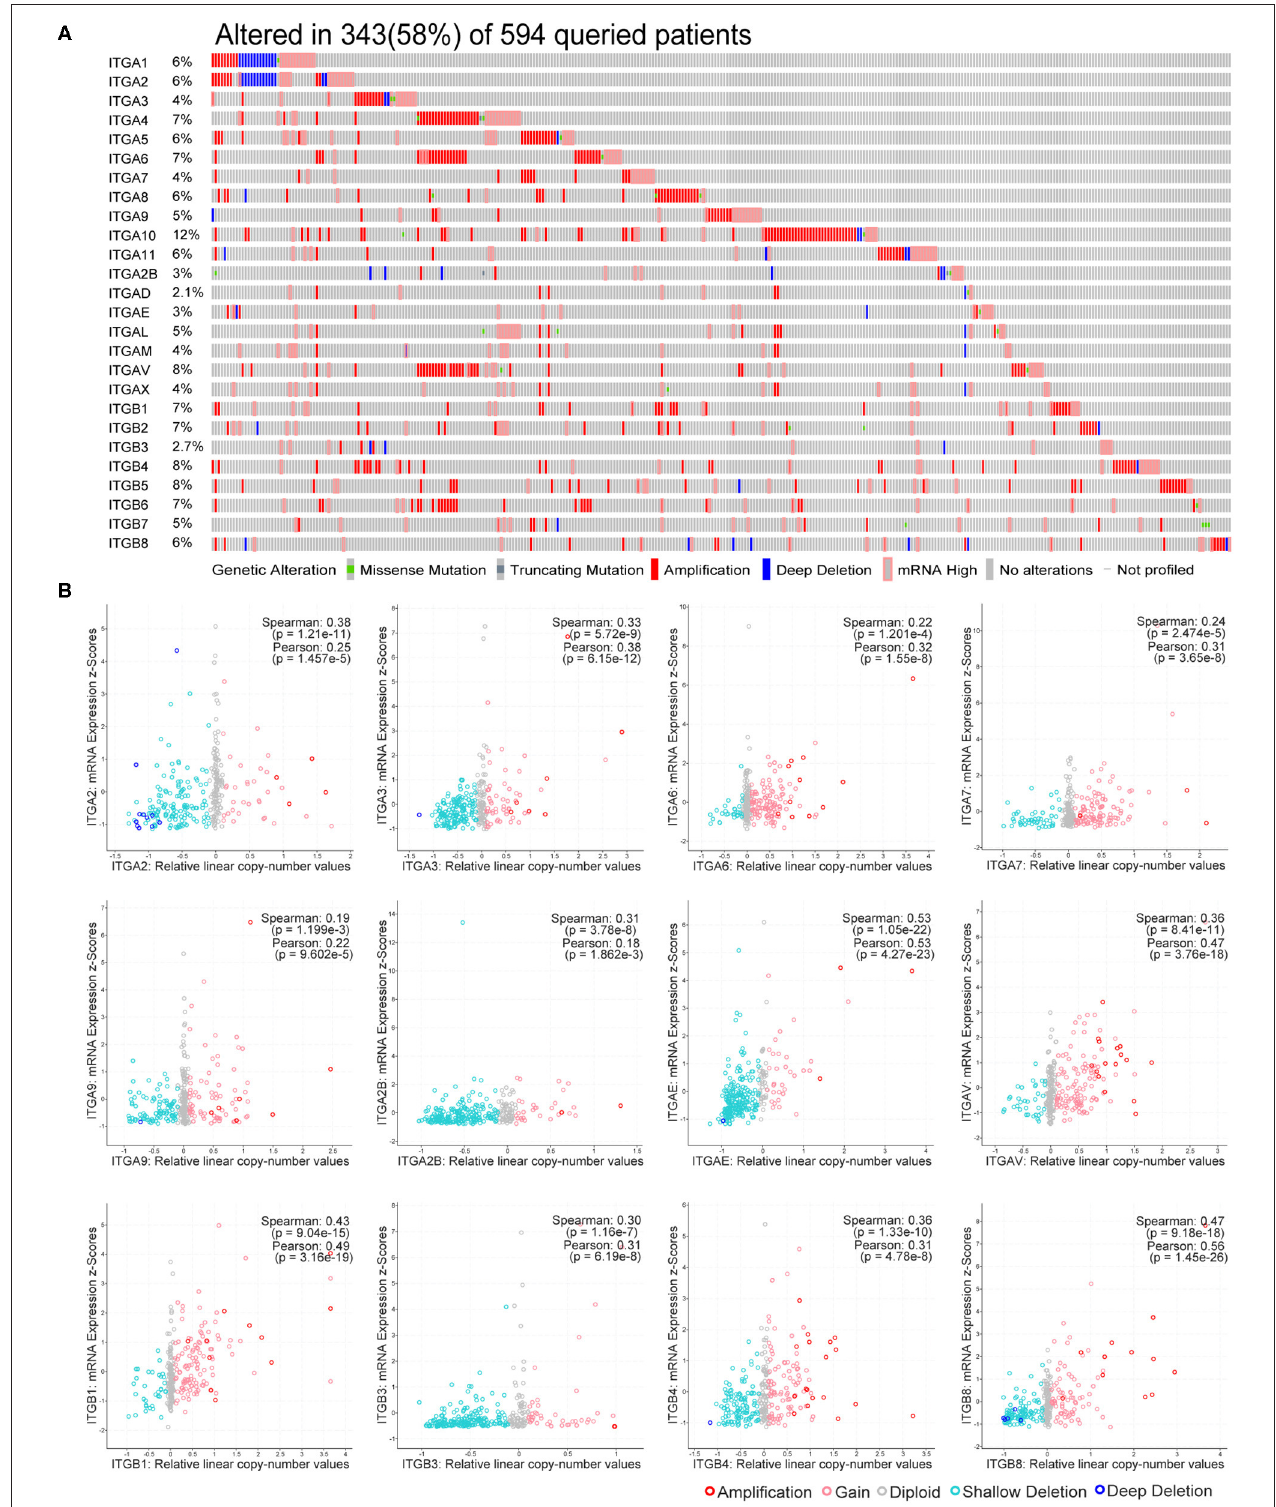
FIGURE 2 | Genetic alteration of integrin genes in OC. (A) Genetic alteration percentage of integrin genes in OC. (B) Correlation of each integrin gene mRNA level and linearized copy-number alteration.